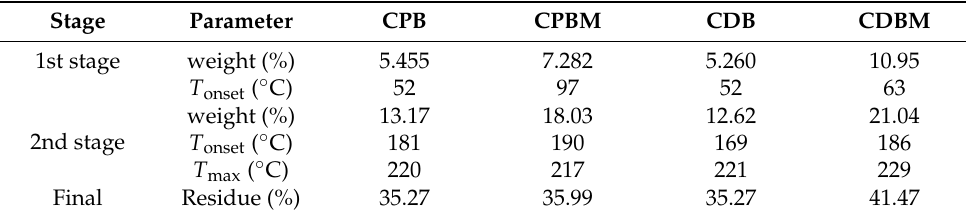
Table 2. Thermal analysis parameters for chitosan/pectin without (CPB) and with MB (CPBM) blend hydrogels, and chitosan/DNA without (CDB) and with MB (CDBM) blend